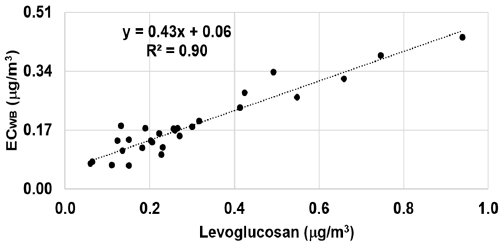
Figure 5. Scatterplot of EC from wood burning (EC WB ) vs. levoglucosan on Propata dataset. Multiple linear regression was carried out for OC source apportionment as explained in par.